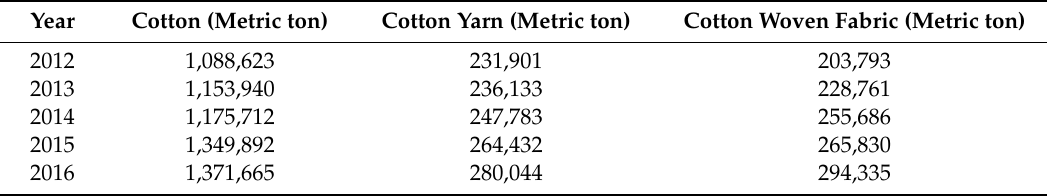
Table A4. Amount of imported cotton, cotton yarn and cotton woven fabric for the five years from 2012 through 2016